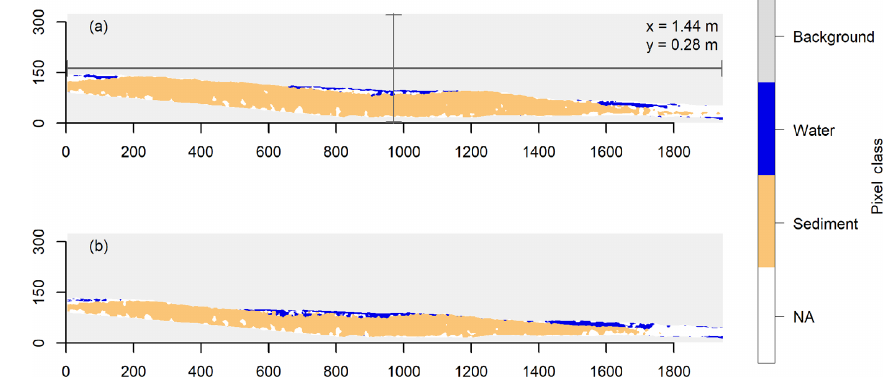
Figure 4. Output after image classification at the onset of output for experiment 100L using (a) GSD broad ( T = 326min) and (b) GSD narrow ( T = 149min). Axes are pixel values of the raster, and real distances are provided for